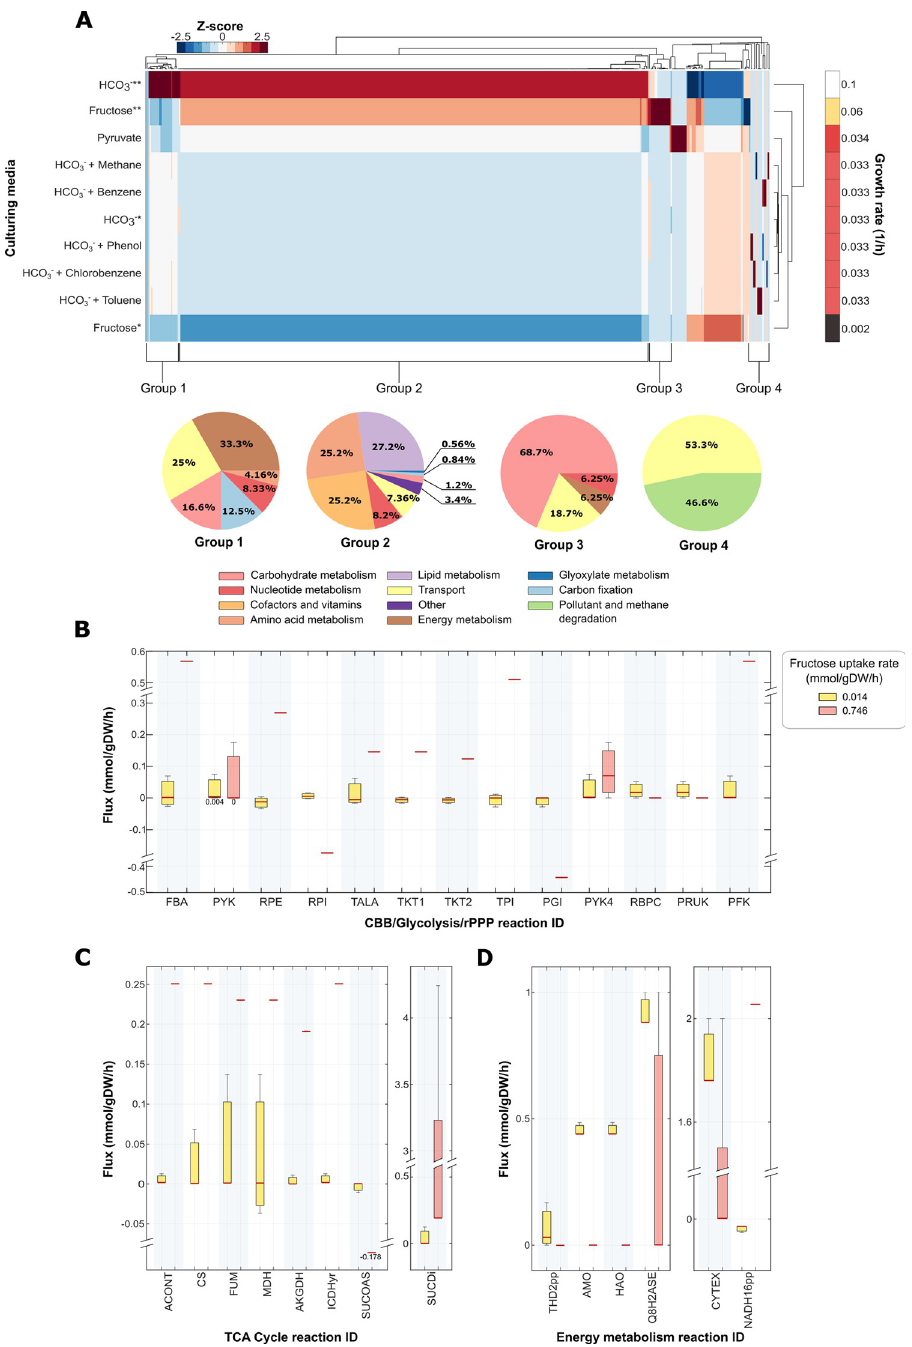
Fig 3. Flux distribution analysis under different growth conditions. (A) Hierarchical clustering of flux distributions under different carbon sources and growth conditions. The HCO 3- uptake rates were established at low and high levels, as we mentioned in Section 3.5.1. The pyruvate uptake flux (0.0773 mmol/gDW/h) used as a constraint in the simulations, resulted from the experimentally observed growth rate of 0.034 1/h [16] when Ne is grown using pyruvate as the organic carbon source. The methane and pollutant uptake rates were constrained to 1 mmol/gDW/h under the low HCO 3- level condition. We used standararized Z-scores to normalize predicted fluxes. Z-scores represent negative and positive values in a blue to red color scale. The X-axis shows the metabolic reactions, and the Y-axis shows different growth conditions. � means low uptake rates; �� means high uptake rates. Group 1: 24 reactions; Group 2: 353 reactions; Group 3: 16 reactions; Group 4: 15 reactions. (B) Change in flux predictions of CBB cycle, glycolysis, rPPP reactions when fructose uptake is at low or high concentration. (C) Change in flux predictions of TCA cycle